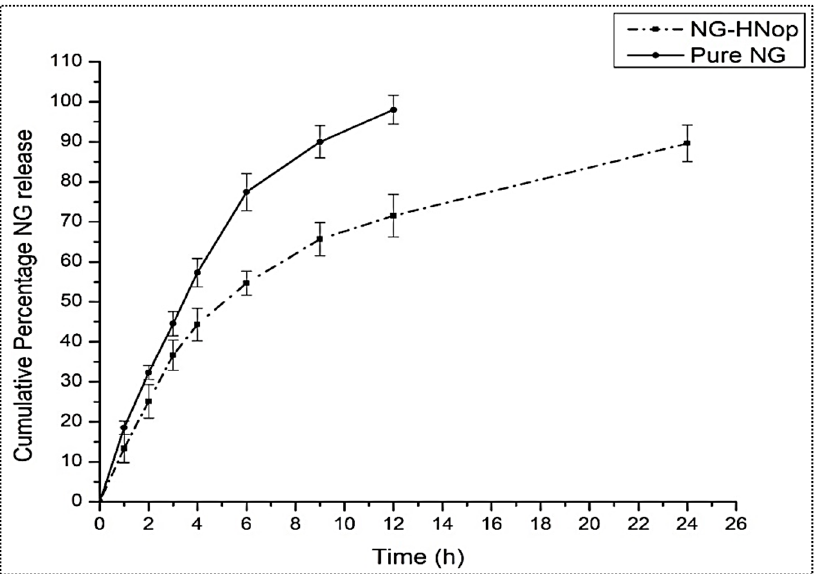
Figure 5. Comparative in vitro release of pure Naringin (NG) and Naringin hybrid nanoparticles (NG-HNop). The study was performed in triplicate and the data are shown as mean ± SD.